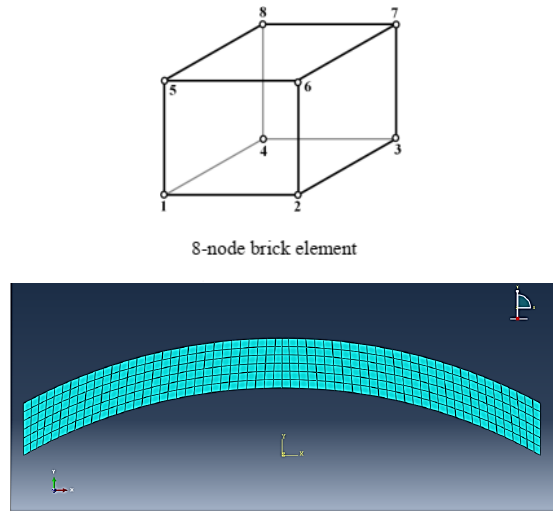
Figure 2: Meshed 2D model